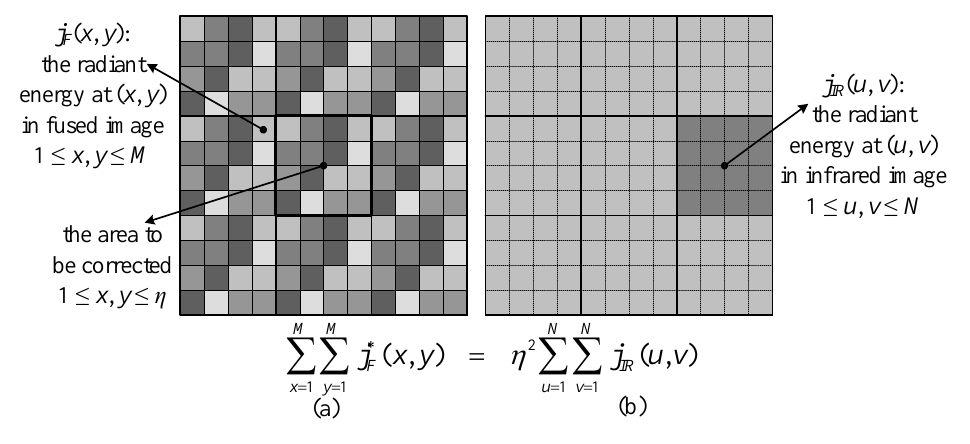
Figure 3. Improved physical correction. ( a ) An M × M area in the fused image is used to correct the highlighted η × η window in the center. ( b ) An N × N area in the low-resolution IR image. The objective is to let both areas in (a) and (b) have the same radiation